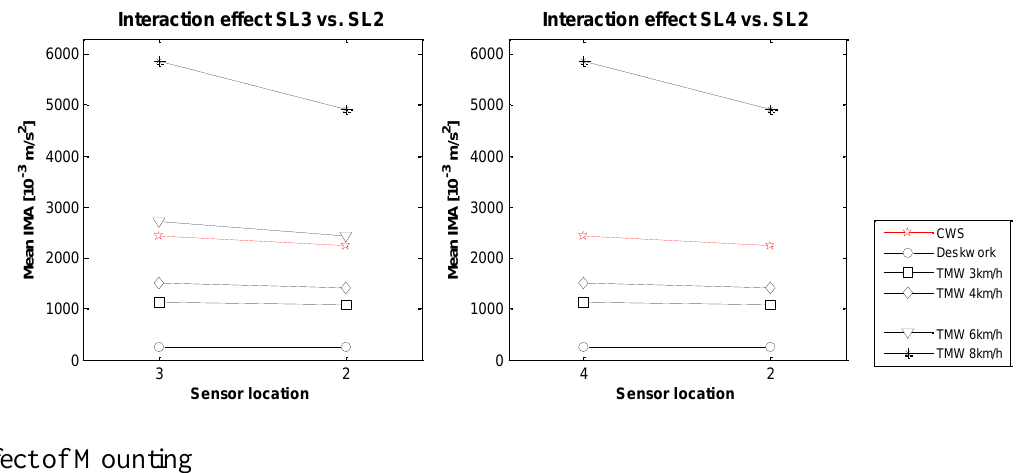
Figure 8. Interaction effects of sensor location and type of setting. Mean IMA values of all 10 subjects for the significant interactions. ( Left ), Location 3 vs . 2; ( Right ), Location 4 vs .